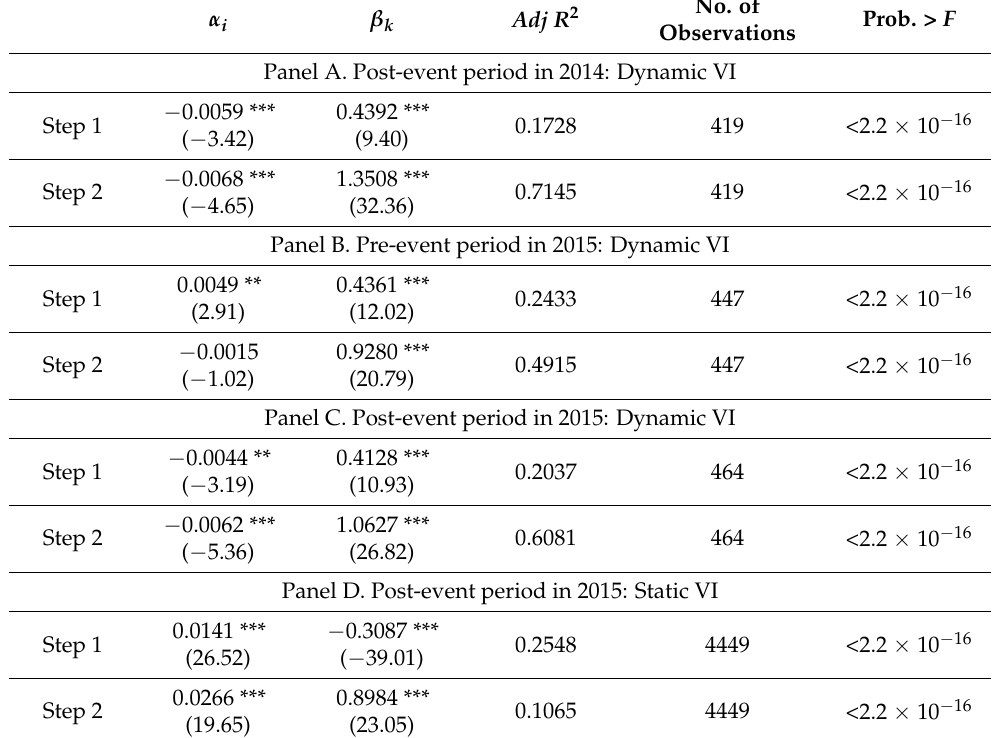
Table 5. Price-discovery effect of VIs. This table provides the estimation results of the following two-step regressions, with the analyses for dynamic and static VIs performed separately over the respective subperiods. ** and *** denote the 5% and 1% statistical significance, respectively. Step 1: (cid:16) (cid:17) (cid:16) (cid:17) (cid:0) (cid:1) = = α + β + e ln P i , post / P i , pre P i , last / P i , pre P i , auction / P i , last α 2 + β 2 e i + η i , where i ; Step 2: ln 1 1 ln P i , pre ( P i , post ) denotes the reference price before (after) the VI is invoked, which is measured by the mean of the mid-price of the best quotes during the ten minutes before the VI is invoked (after the call auction is completed). P i , last and P i , auction denote the last execution price before the VI is invoked and the call auction price, respectively. The subscript i indexes individual firms, and e i and η i are residuals of each regression model. Parentheses denote t -values and k denotes the